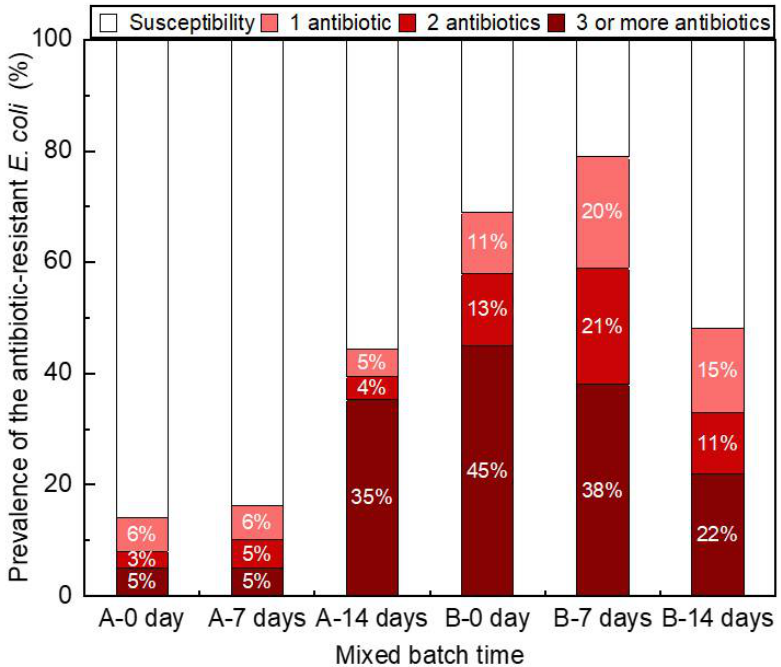
Figure 2. A bar chart of the cumulative percentage of E . coli isolates from plants A and B that were resistant to 1, 2, and 3 or more antibiotics.